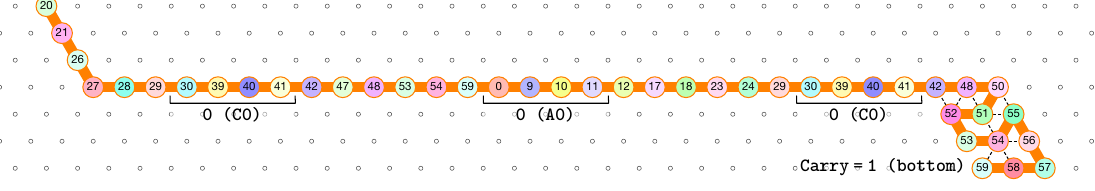
Figure 5. The seed configuration for the 3-bits counter encoding the three bits 000 as the initial value of the counter.